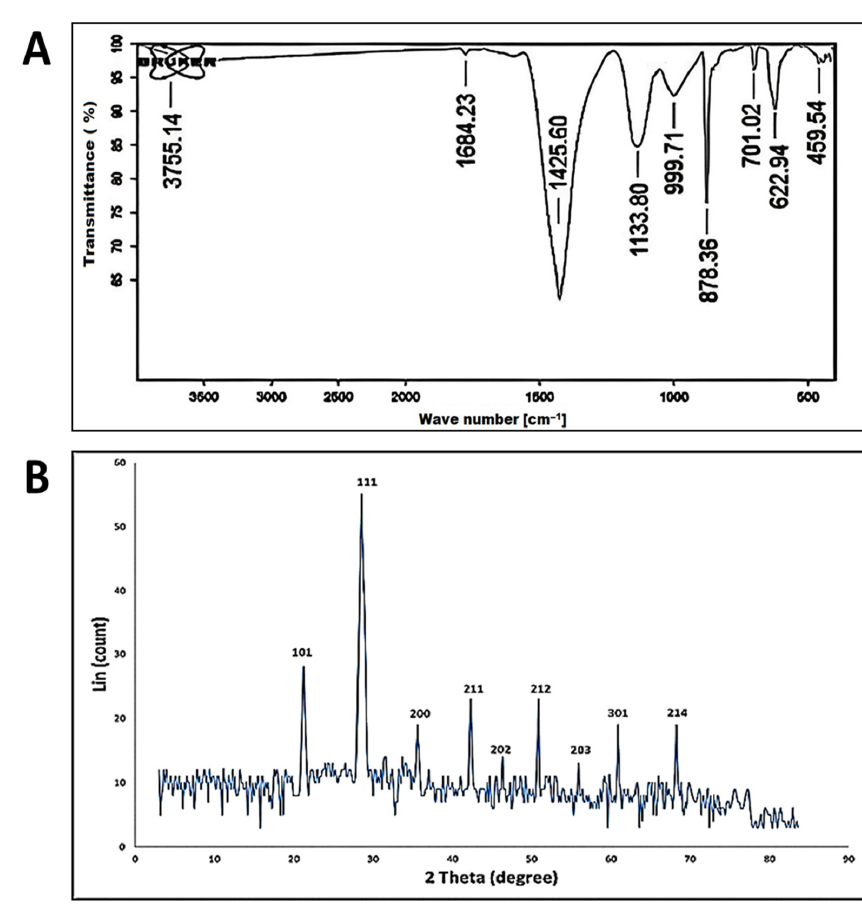
Figure 2. FT-IR spectra ( A ) and XRD diffractogram of SiO 2 -NPs ( B ).